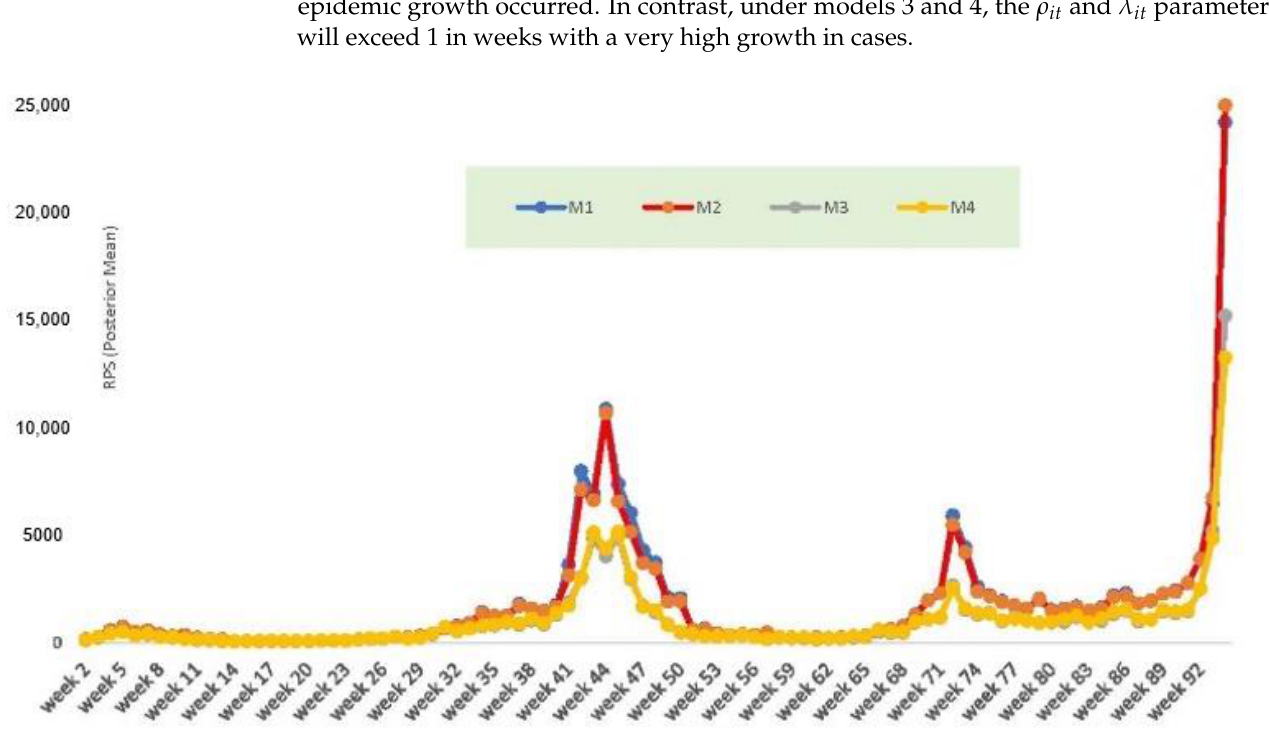
Table 2. Weeks with Highest Growth in Cases, Total Areas (from 32) with 𝜌 𝑖𝑡 > 1.